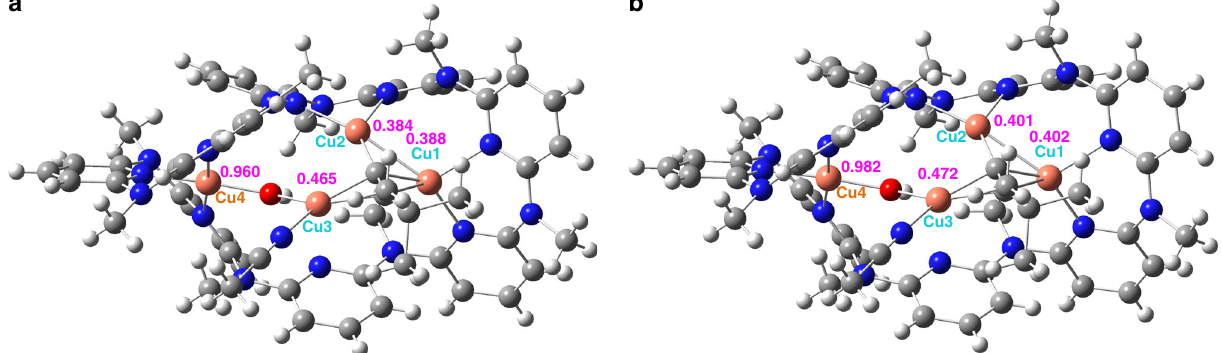
Fig. 5 NBO analyses for the charge distribution of metal ions in complex 1 . a NBO calculation in gas phase. b NBO calculation in acetone. Color codes: Cu, orange; N, blue; O, red; C, gray; H, light